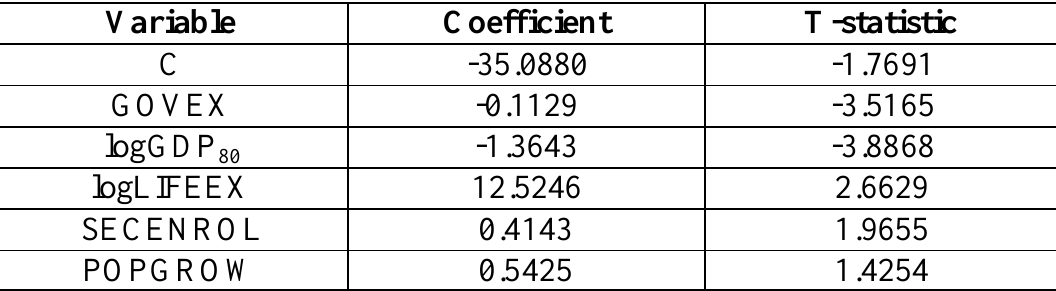
Classic growth regression